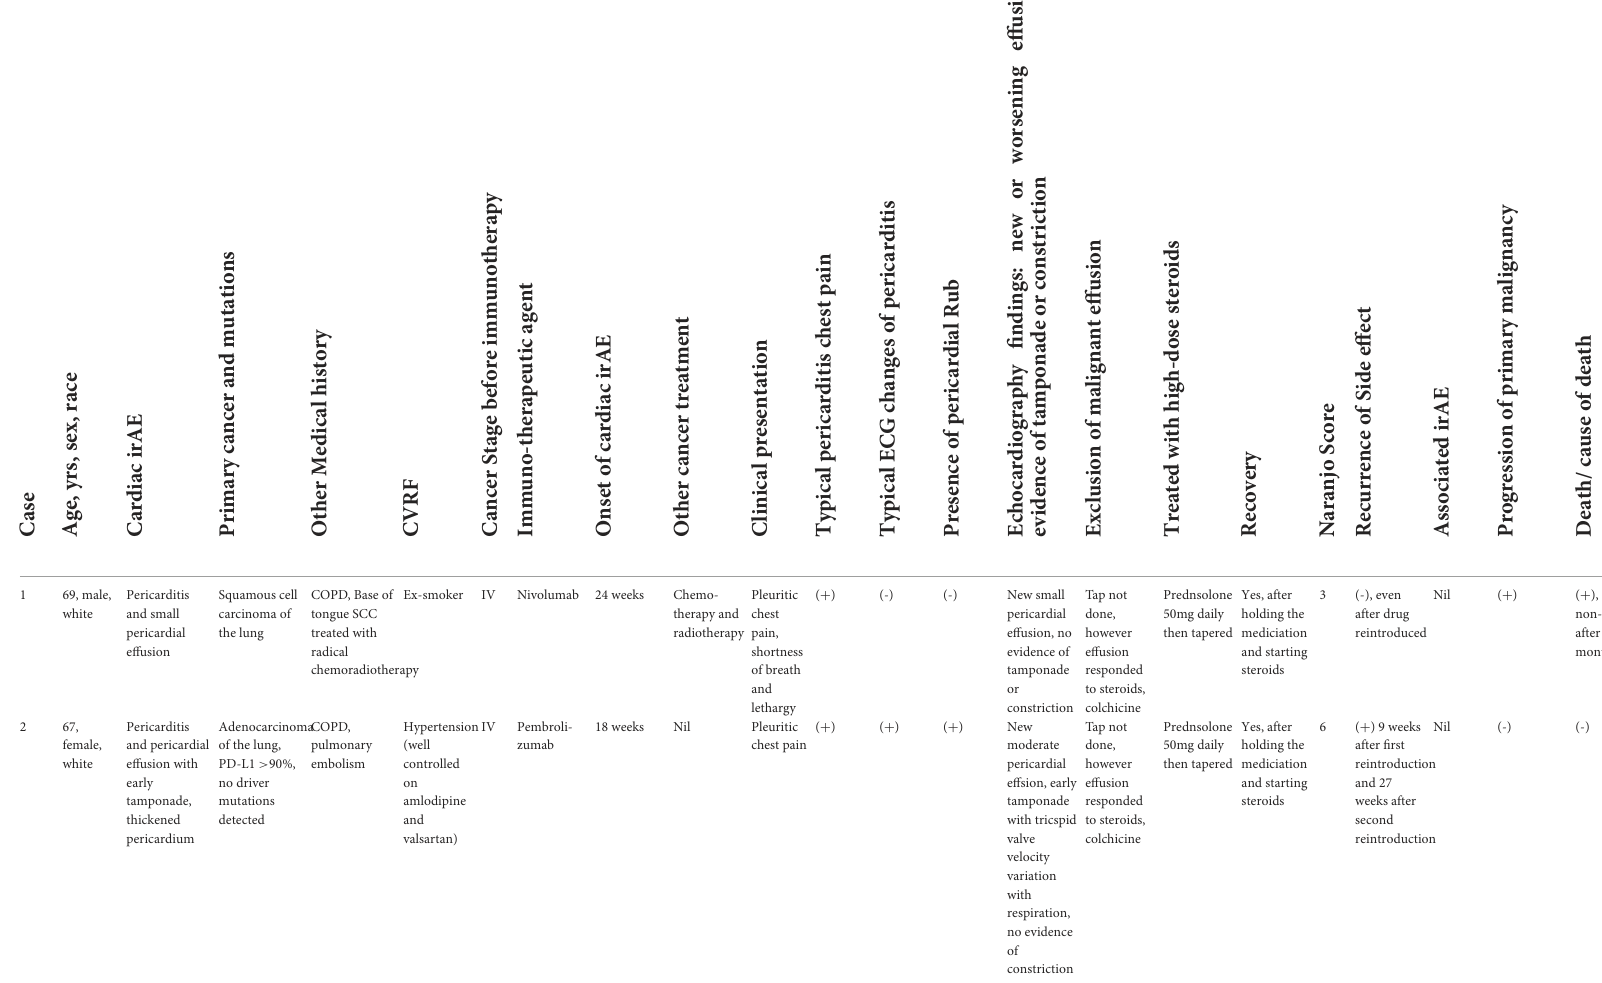
TABLE 1 Characteristics of patients who developed pericardial disease due to immune checkpoint inhibitors.